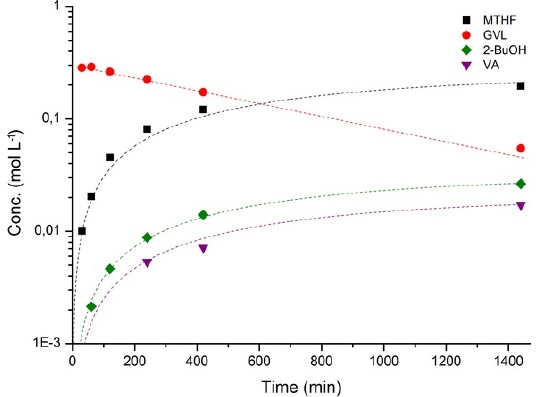
Figure 6. Concentration of the reaction products as function of the reaction time (dots) for 23Ni– 12Cu/Al 2 O 3 and data fitting (lines). Reaction conditions: 5 wt% LA in 2-PrOH, LA/cat. ratio 10 g/g, 230 °C reaction T, 70 bar H 2 . Reprinted with permission from [186]. Copyright 2015 Wiley and Sons .